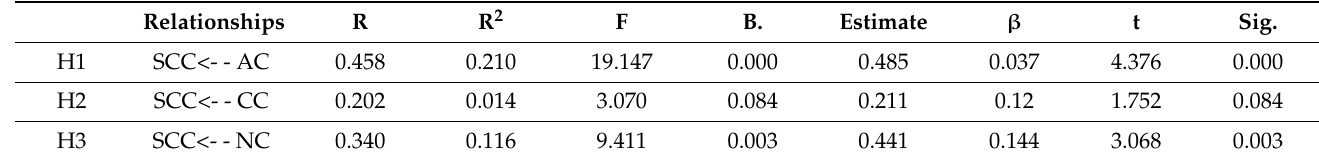
Table 2. The results of simple regression